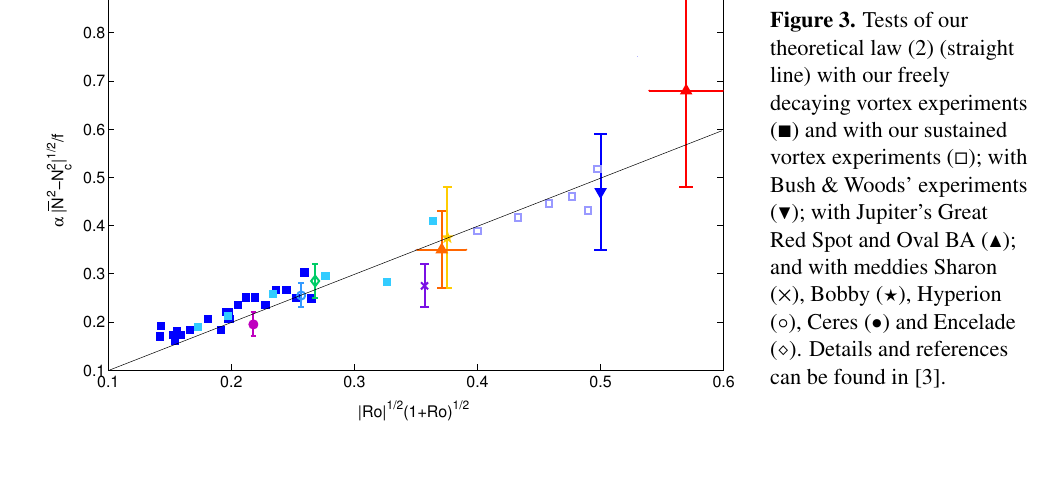
Figure 4. Theoretical v profile given by the model (3) ( − ) compared with the experimentally obtained velocity profiles ( (cid:63) ) in the centered horizontal plane ( z = 0). Ro and L being the two parameters of the model in this plane, they are given by the best fit of the model with the experimental curve: ¯ N = 1 . 6 rad / s, N c = 0 rad / s, f = 6 . 8 rad / s and the measured parameters are Ro = 0 . 17 and L = 2 . 58